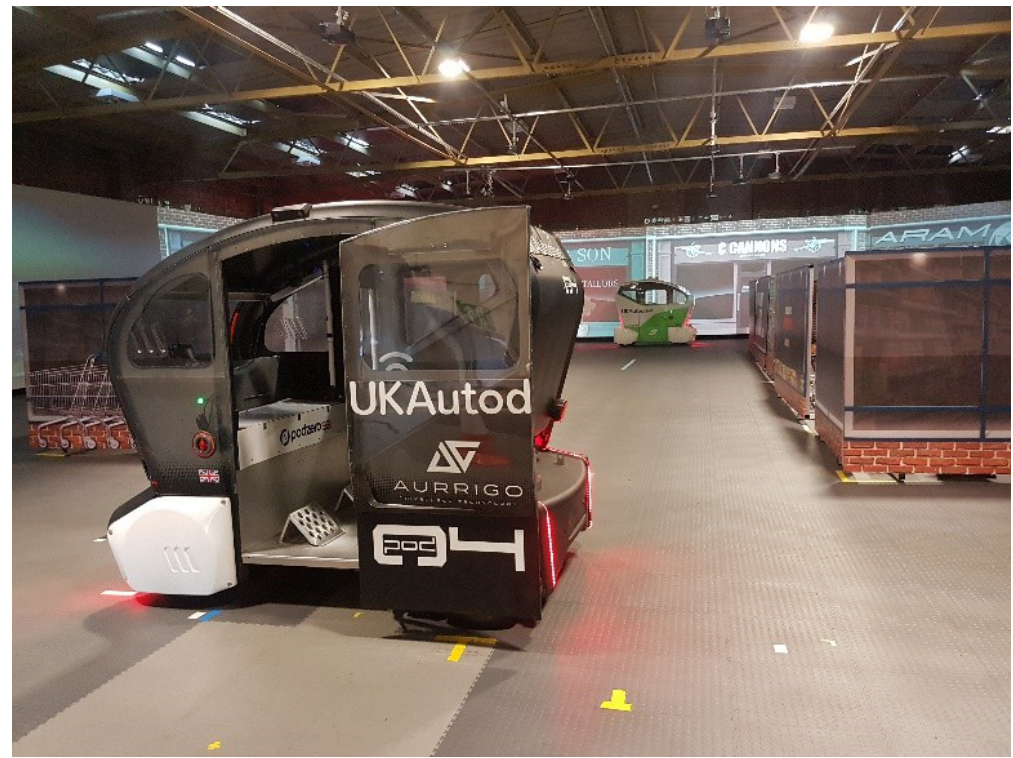
Figure 1. Vehicles used during this study, manufactured by RDM/Aurrigo, parked at opposite sides of the arena prior to the start of a user trial.